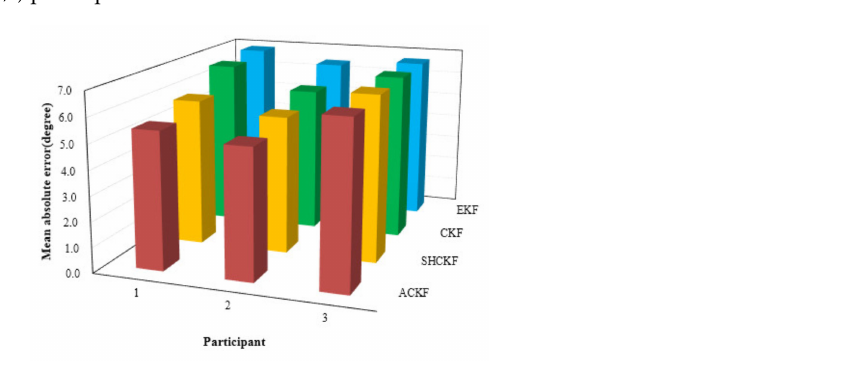
Figure 8. Distributions of heading and the absolute value of heading error for three participants, ( a , b ) participant 1, ( c , d ) participant 2, and ( e , f ) participant 3.